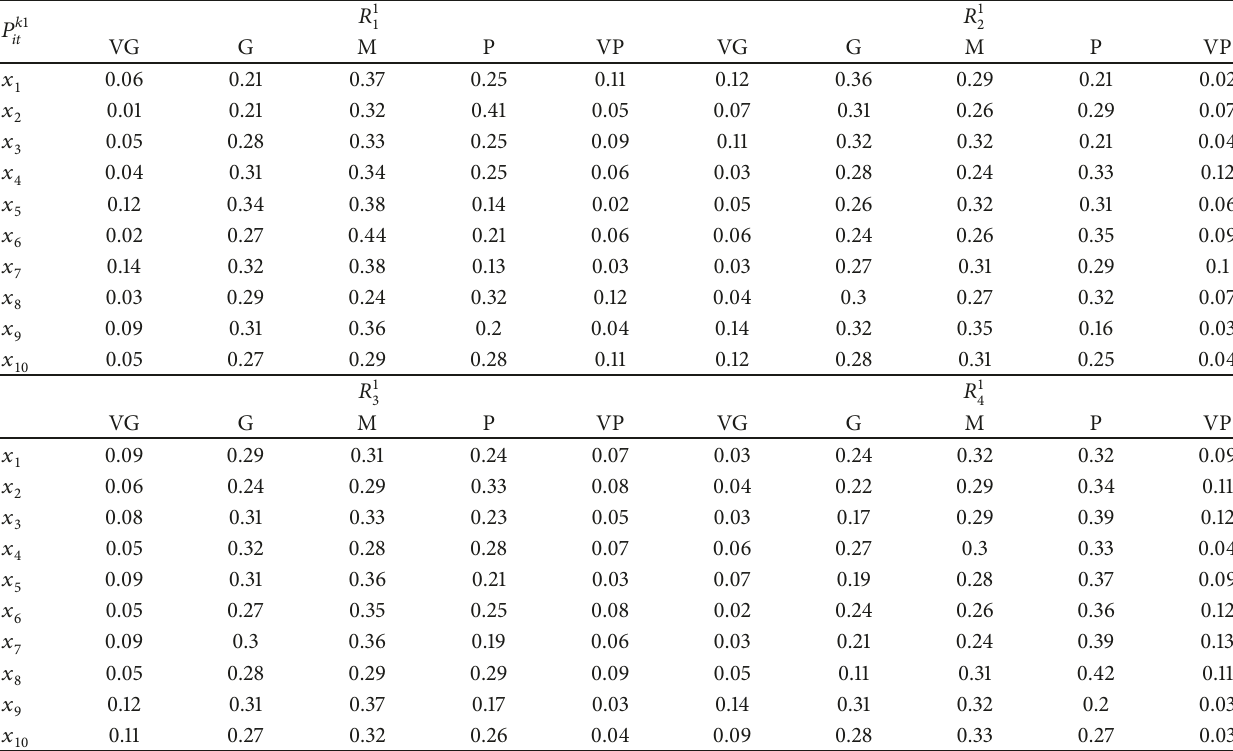
Table 2: The evaluation values with respect to the dimensions ability.